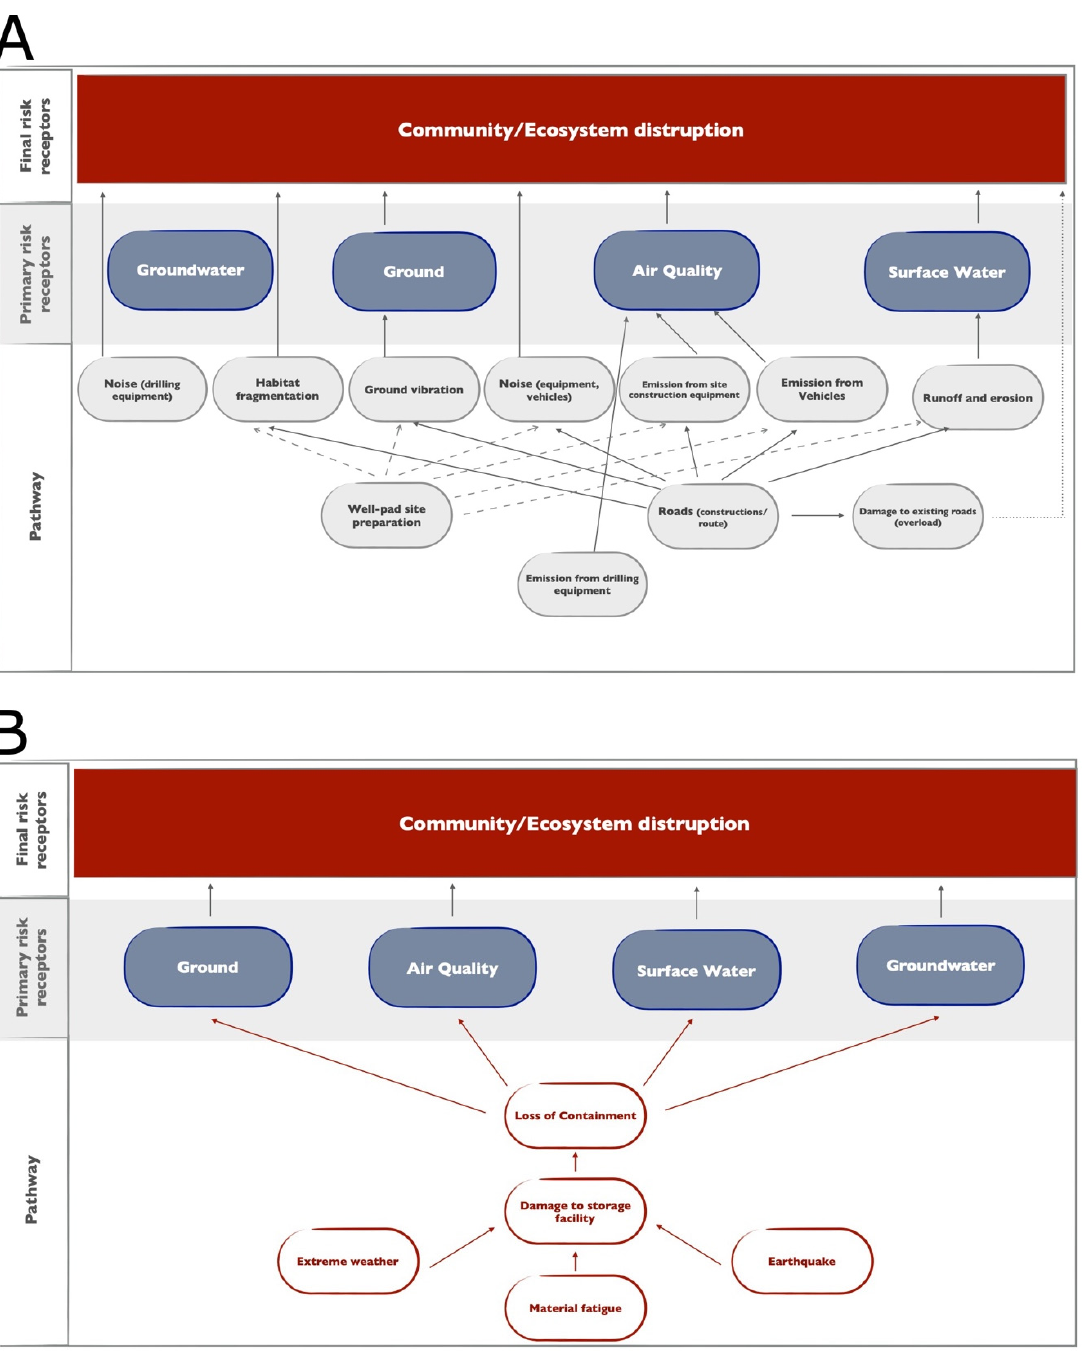
Figure 8. Risk pathways in Phase 1: Site construction and drilling. ( A ) Grey circles identify events related to ordinary routine operations, i.e., mostly of LCA analysis; ( B ) Red circles identify events related to incidents and/or extreme events, i.e., those more closely related to MRA.